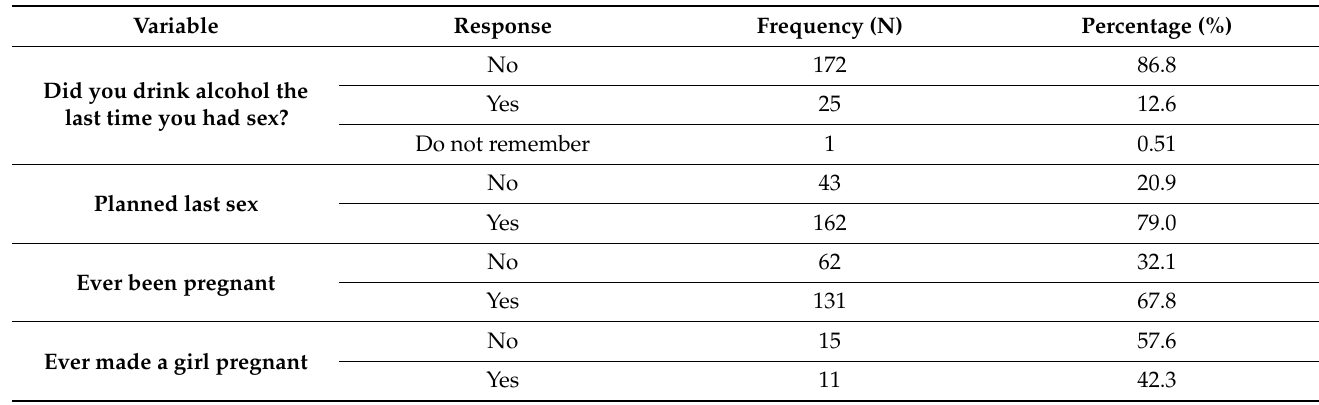
Table 5. Alcohol uptake (n = 201) by